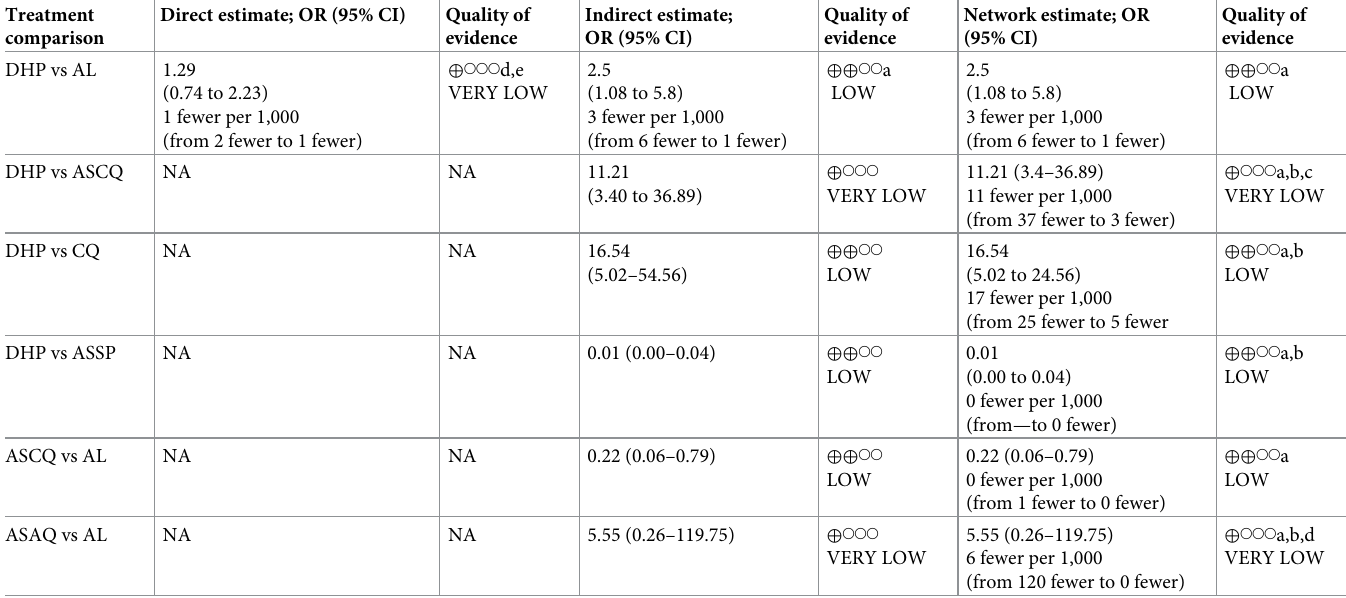
Table 2. GRADE quality of evidence for the comparative efficacy of antimalarial. Treatment